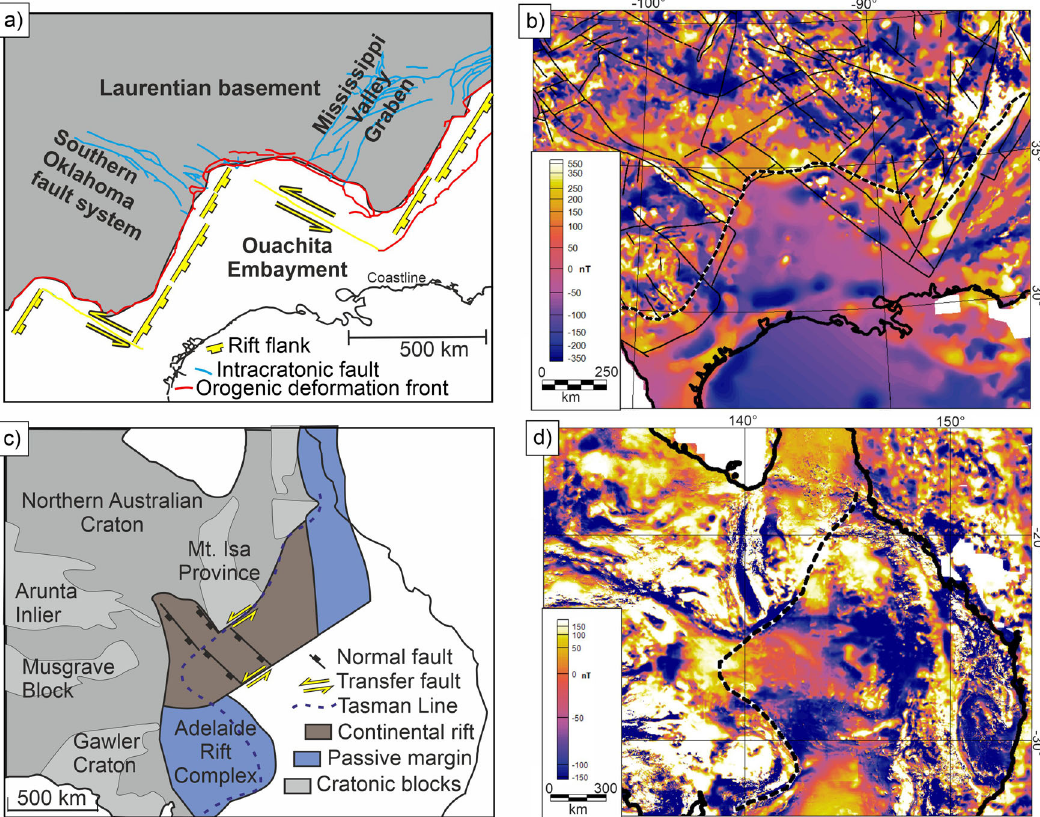
Fig. 4 Analogous embayments in magnetic cratonic basement created by rifting. a Sketch of late Neoproterozoic to early Cambrian Ouachita Embayment and extent of subsequent orogenic deformation 39 . b Ouachita Embayment (dashed line) over aeromagnetic data 42 , with additional structural lineations picked from magnetic data (black lines) 44 . c Sketch of late Neoproterozoic rifted margin of Western Australia with continental rift interpreted to underlie Thomson Orogen 41 . d Australian aeromagnetic map 43 . Note embayment in the geophysically de fi ned Tasman Line (black dashed